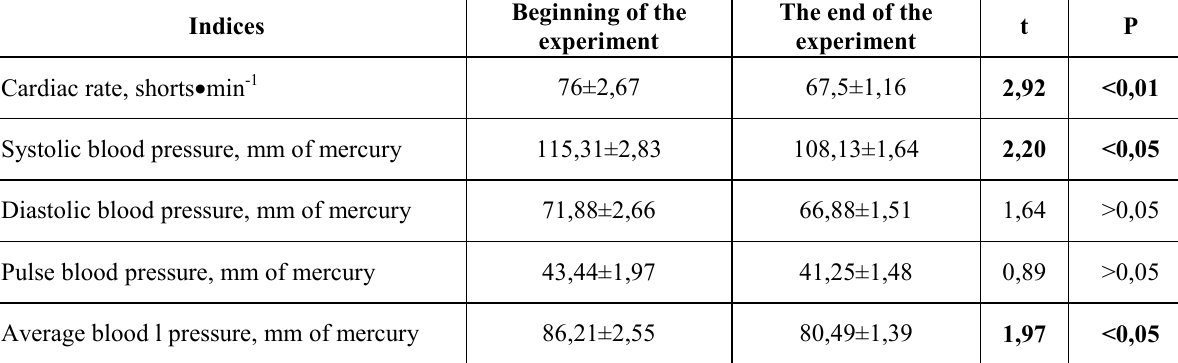
Cardiovascular system indices of the girls of experimental group (n=17) by the end of the forming